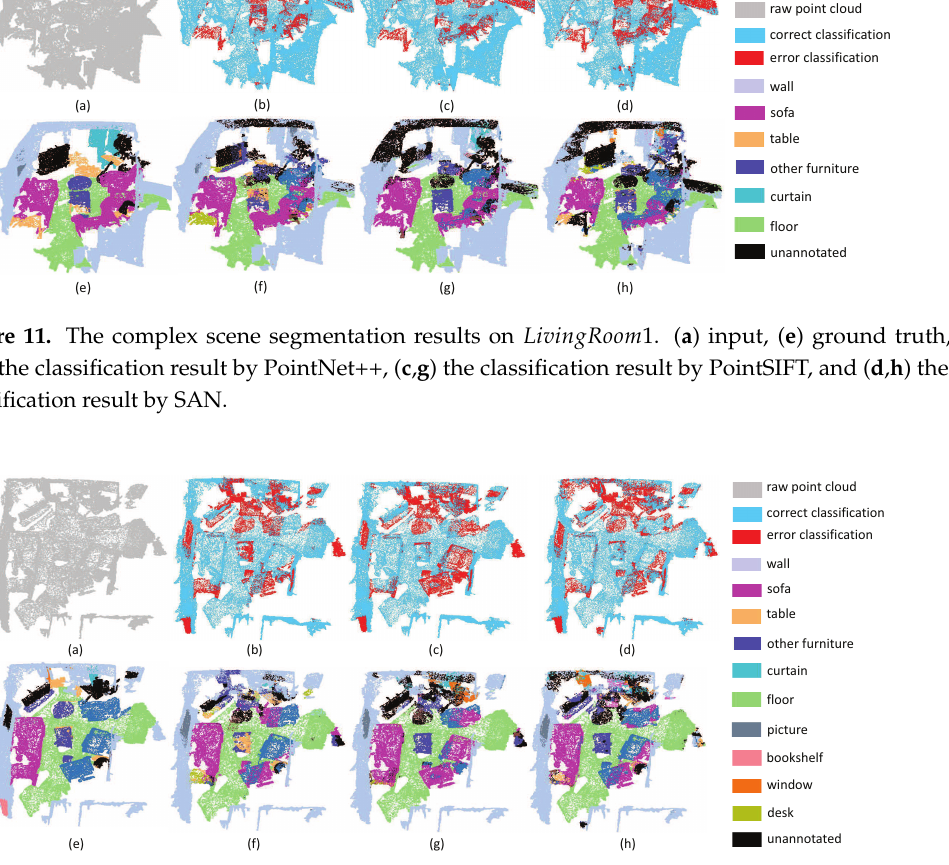
Figure 12. The complex scene segmentation results on LivingRoom 2. ( a ) input, ( e ) ground truth, ( b , f ) the classification result by PointNet++, ( c , g ) the classification result by PointSIFT, and ( d , h ) the classification result by